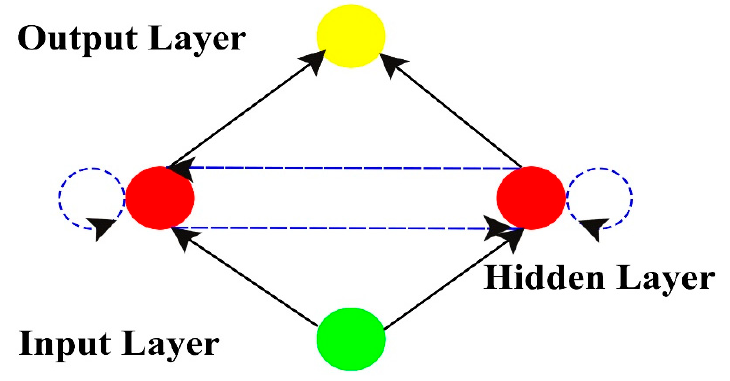
Figure 12. A recurrent neural network architecture. Table 7. Six recurrent neural network-based methods used for bearing fault diagnosis research comparison. Refs.